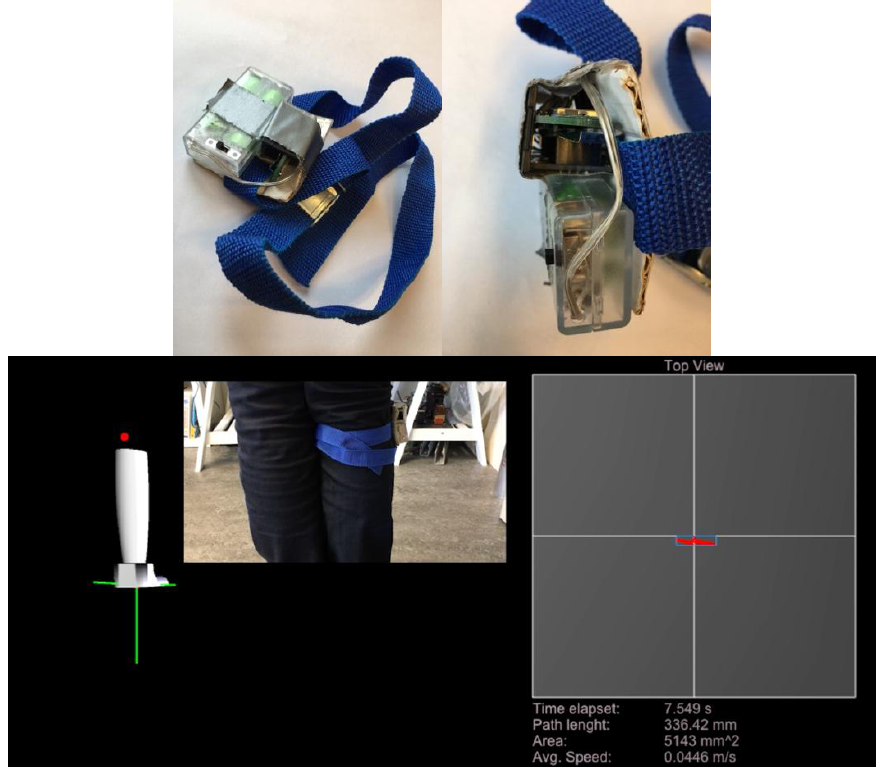
Figure 1. External design of the sensor platform of the Arduino prototype and the user interface with visualized (internal) data.